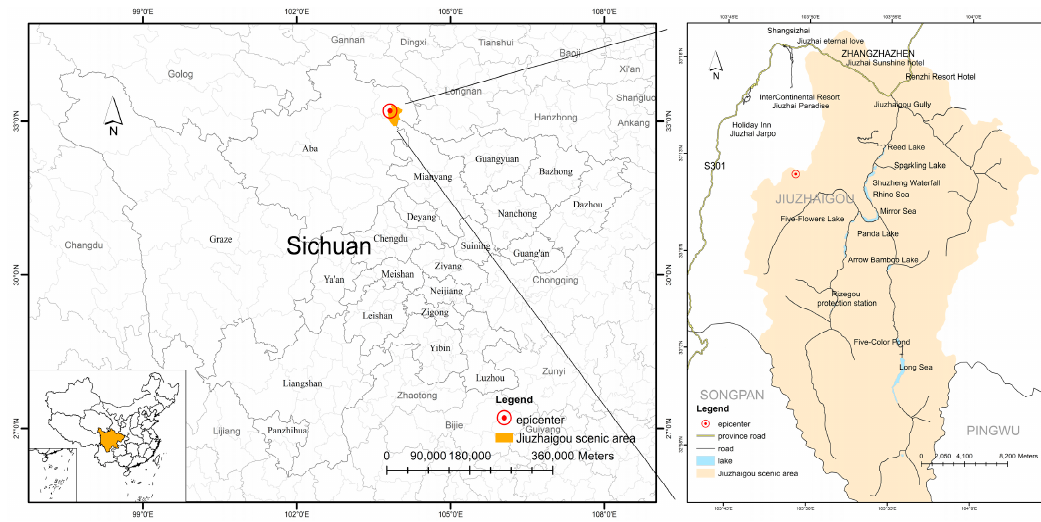
Figure 1. The administrative region of the Jiuzhaigou, Sichuan study area.